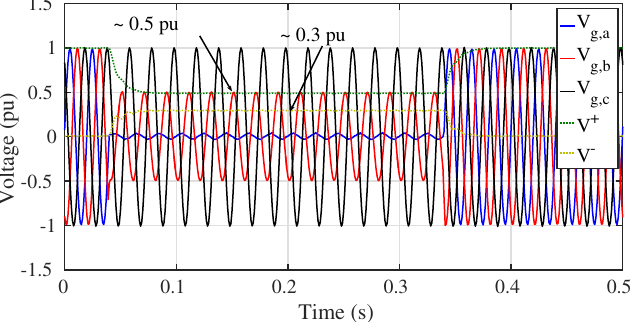
Figure 17. AC voltage waveforms for Experimental Scenario